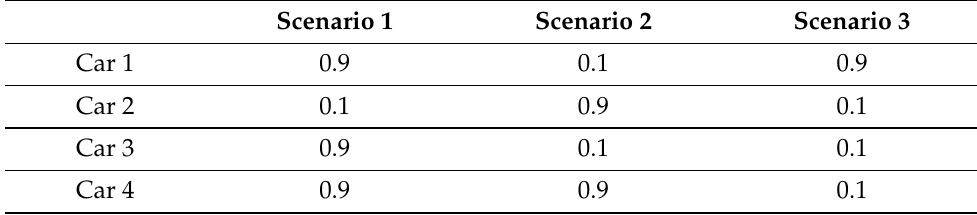
Table 3. Assigned politeness.